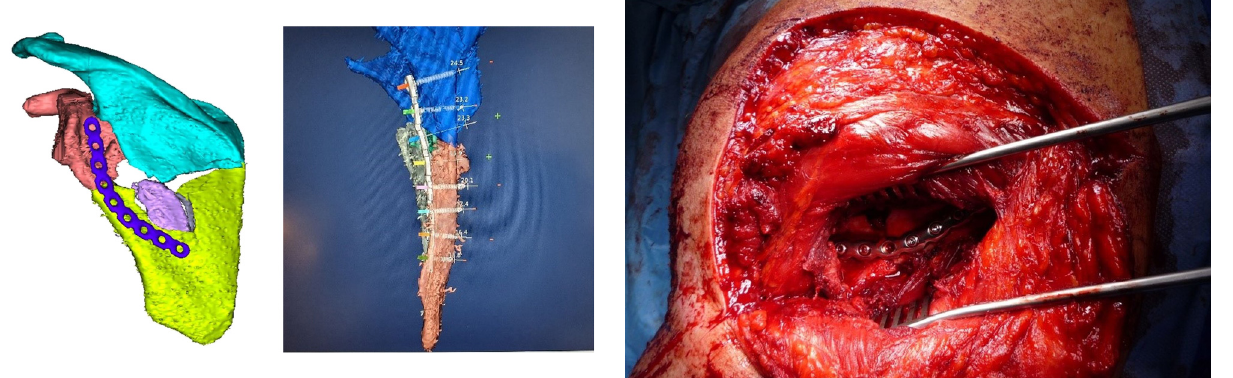
Figure 5: Scapular fracture after the reduction in the TraumaTech software, including optimizing of the implant shape ( left ) and modeling of the fi xation screws ( right ) .